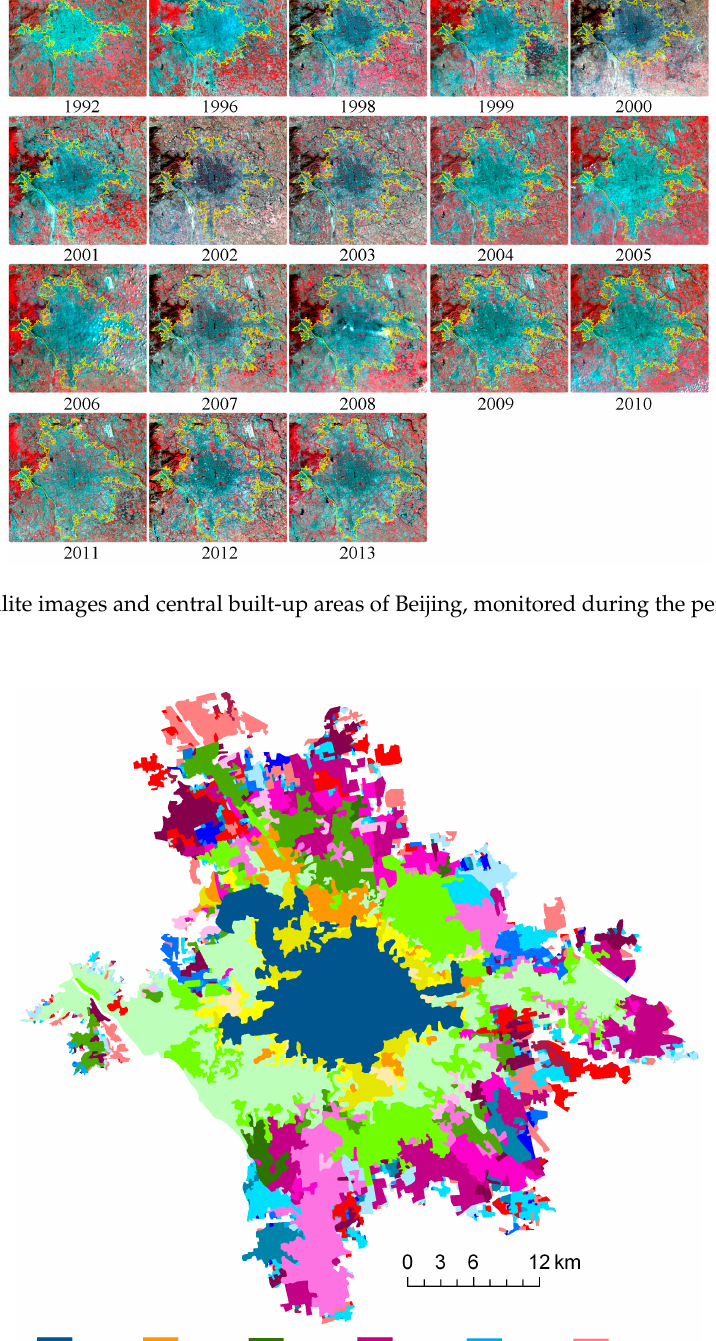
Figure 3. Urban expansion process of Beijing from the 1970s to 2013.